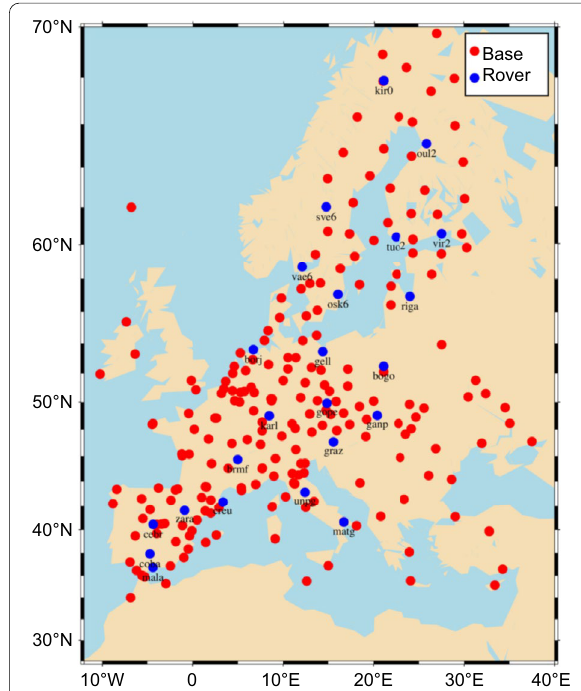
Fig. 1 Distribution of 230 tracking stations over Europe, in which the red denoted 200 stations are used for Q4DIM, while the blue denoted 30 stations are used for